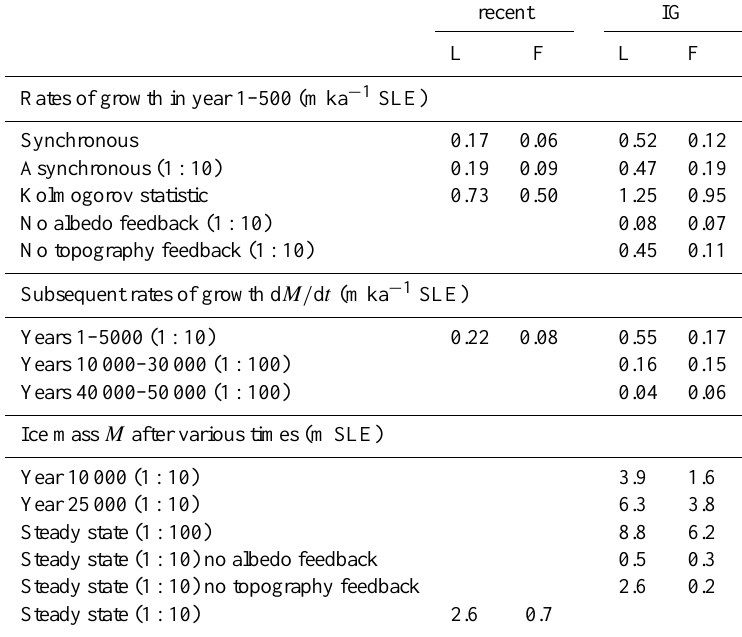
Table 2. Ice-sheet mass M and rates of growth d M/ d t at various times throughout the experiments for the recent and incipient glacial (“IG”) climates. “L” and “F” stand for the Laurentia and Fennoscandia Glimmer domains. The notation 1 : n indicates an asychronous integration with n ice-sheet years for each climate year; in this notation, the synchronous integrations are 1 : 1. The Kolmogorov statistic, which is dimensionless, is used to compare the SMB in the corresponding synchronous and asynchronous integrations, as explained in the text. To convert ice mass in units of metres of sea-level equivalent (m SLE) to ice volume in units of 10 6 km 3 , divide by 2.53.